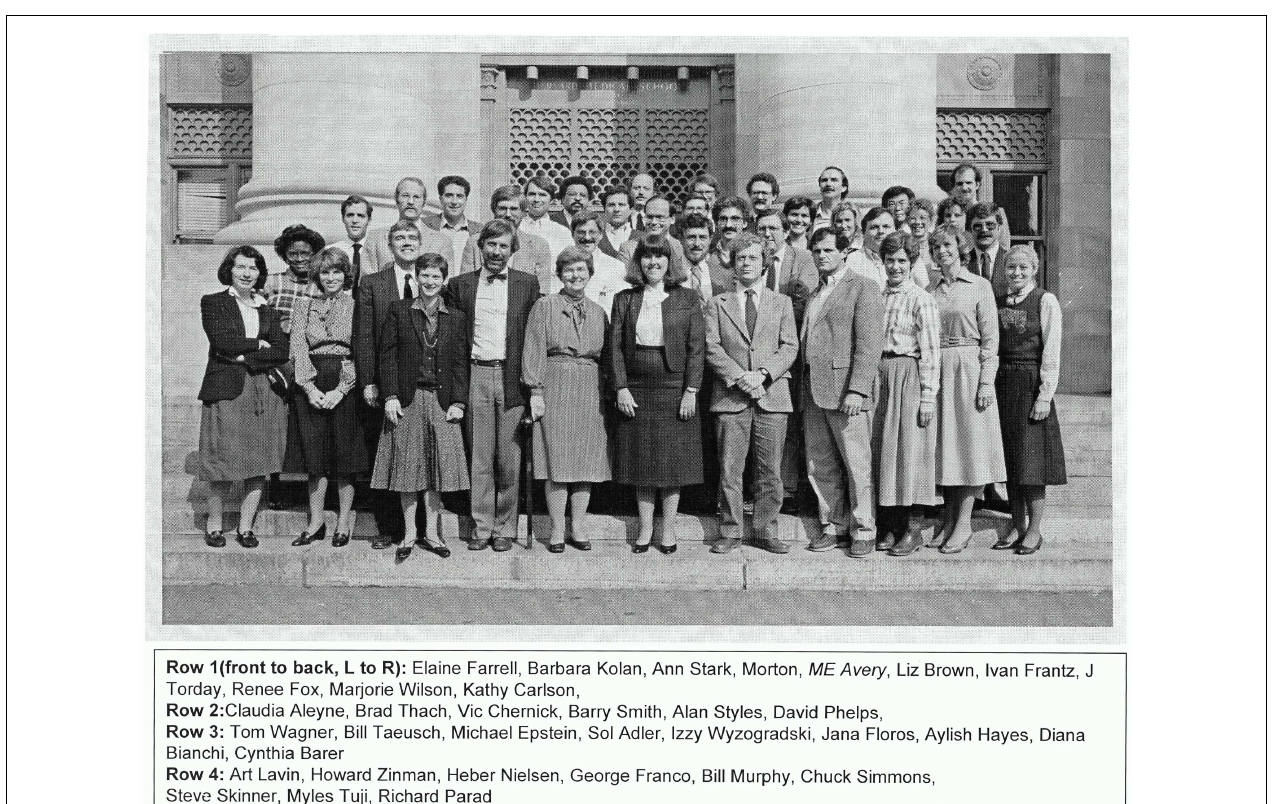
1974, gathered for a group picture with her in front of the administration building at Harvard Medical School.Those in attendance were clinicians, clinician-scientists, and basic scientists alike as the embodiment of Dr. Avery’s eternal effort “to do no